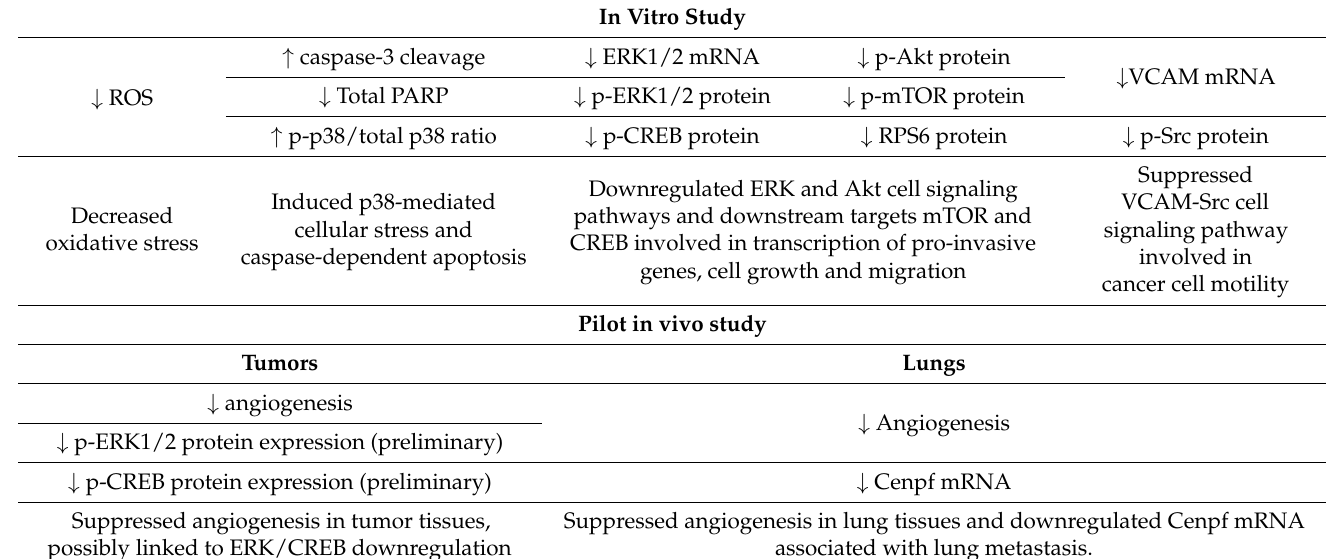
Table 1. Mechanisms modulated by ACN in 4T1 BC cells in vitro and in